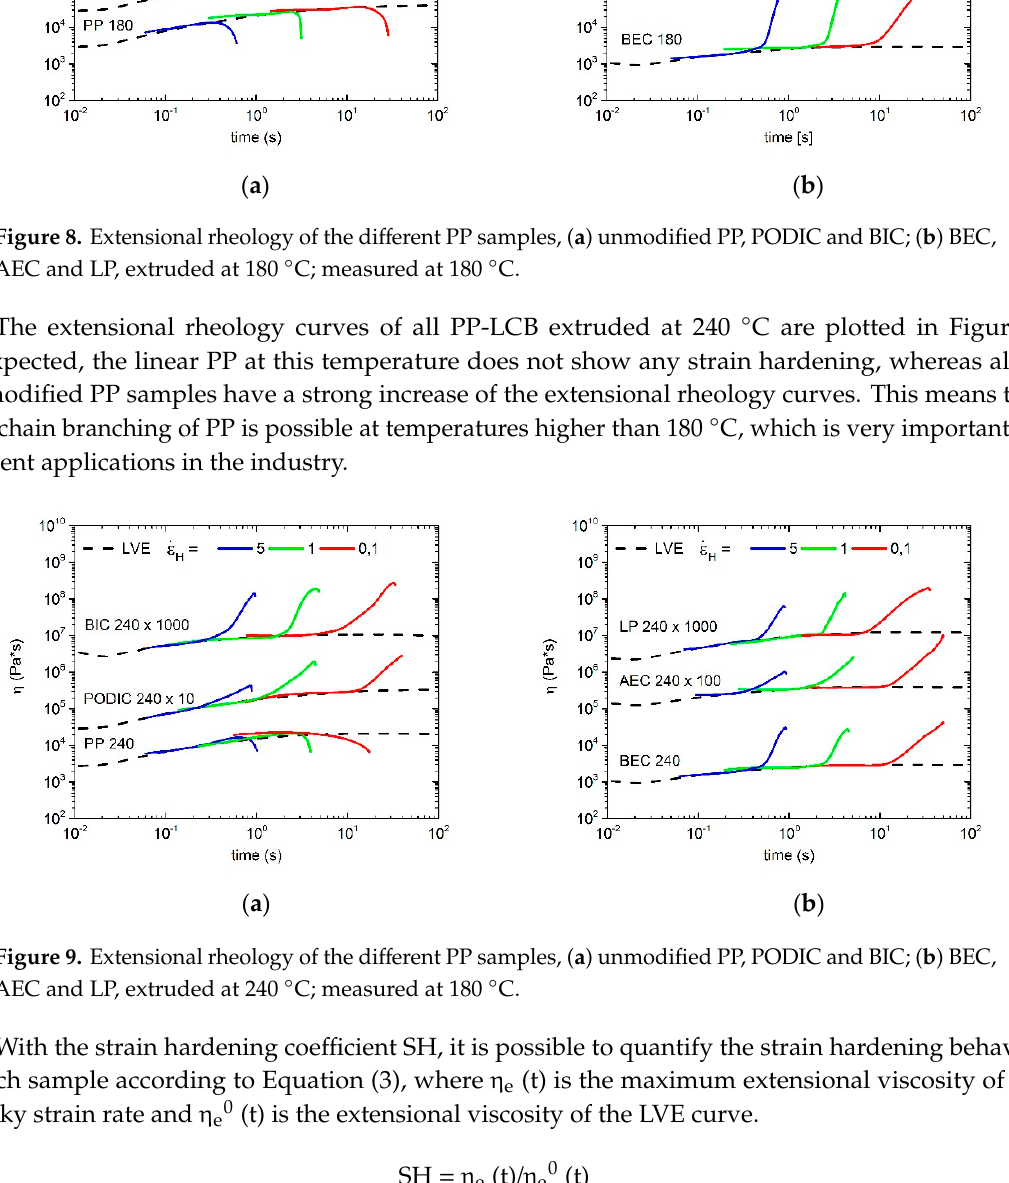
( b ) Figure 10. Strain hardening coefficient at different strains rates (0.1, 1, 5); modified at ( a ) 180 °C and ( b ) 240 °C. 3.5. Mechanical Properties